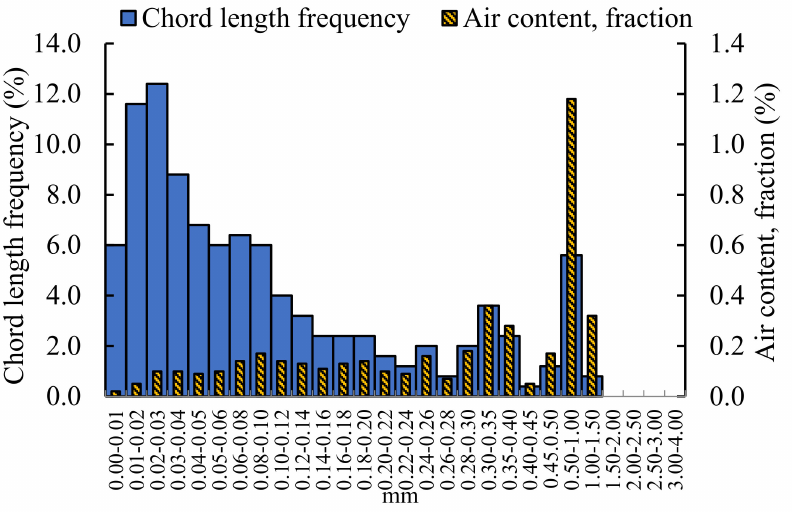
Figure 4. Analysis of pores structure of grouting material without